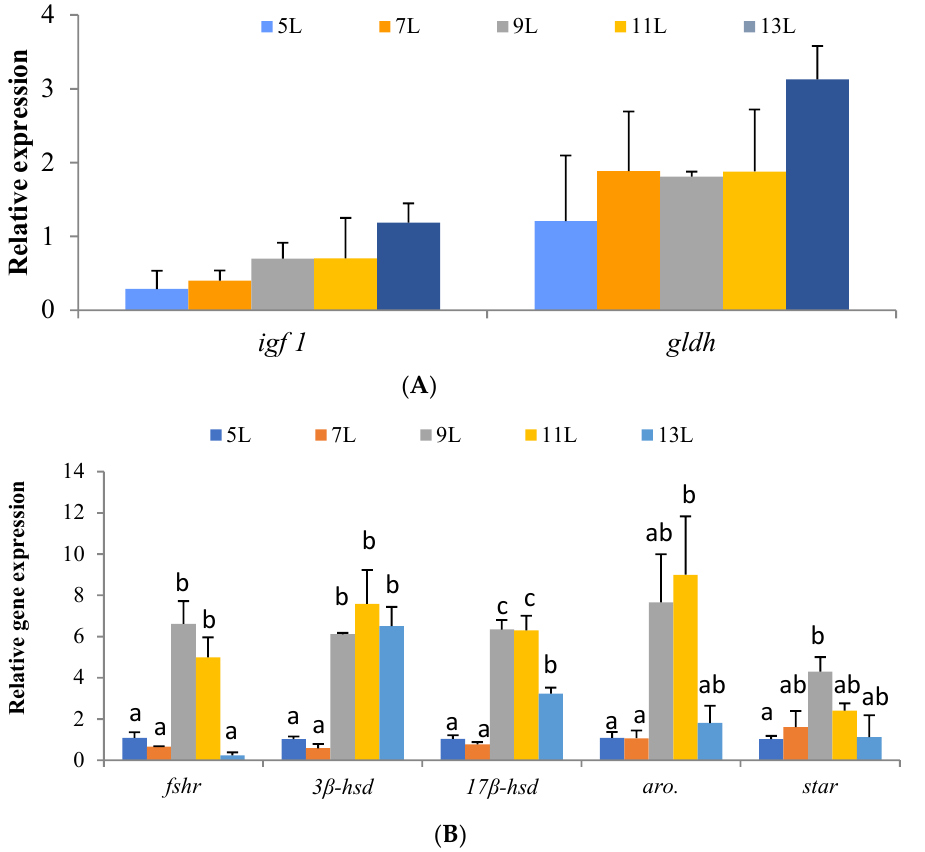
Figure 2. Relative expression values of genes from the hepatopancreas involved in growth and protein metabolism ( igf1 , gldh ; ( A )) and the gonad involved in sex steroid-synthesizing proteins ( fshr , 3 β -hsd , 17 β -hsd , aro. and star. ; ( B )) in Onychostoma macrolepis broodfish fed diets differing in their crude lipid levels. Different letters indicate significant differences.